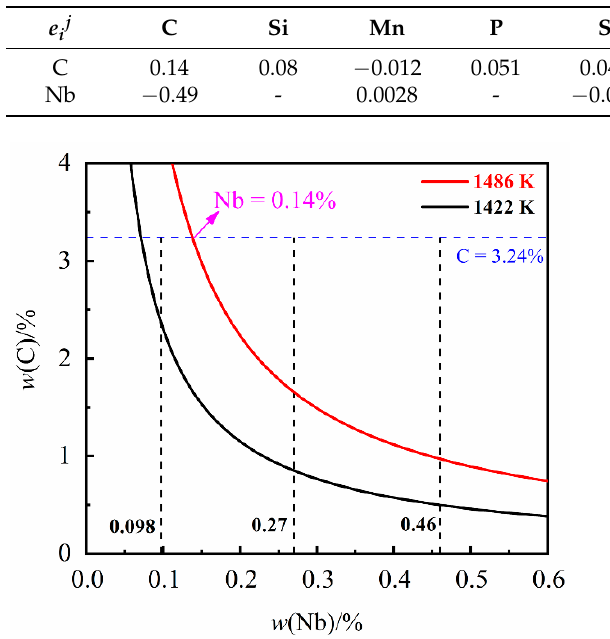
Table 2. Values of first-order interaction coefficient of elements in molten iron [16,17].